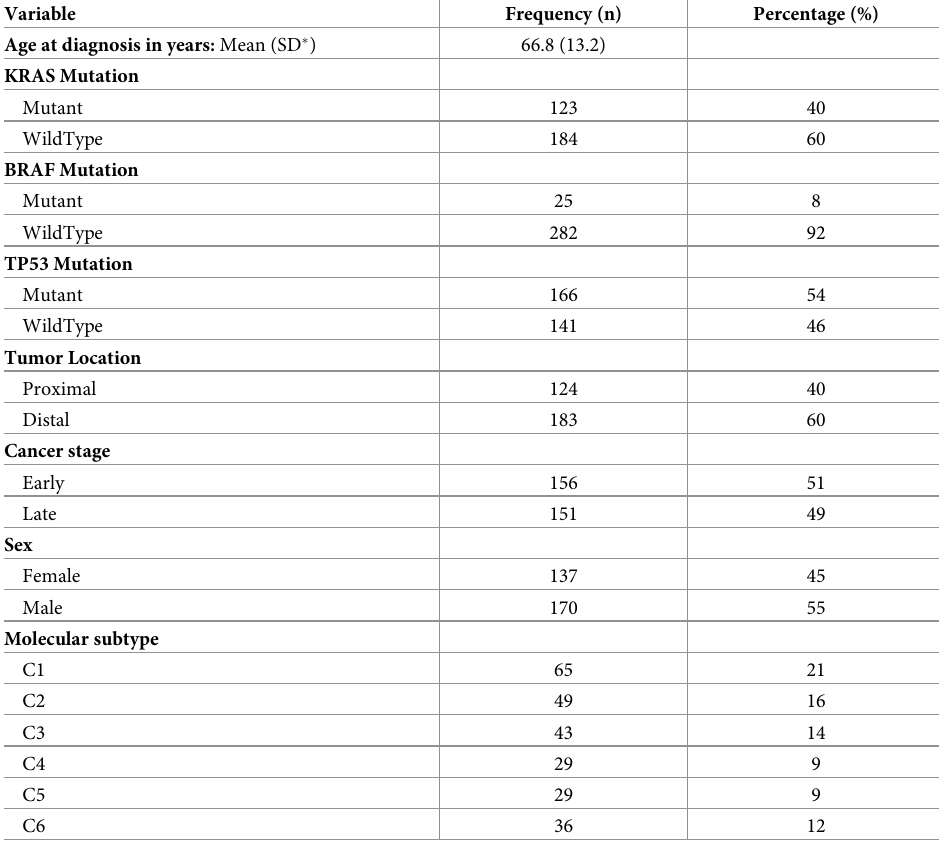
Table 1. Clinical characteristics of colorectal cancer patients (N = 307).